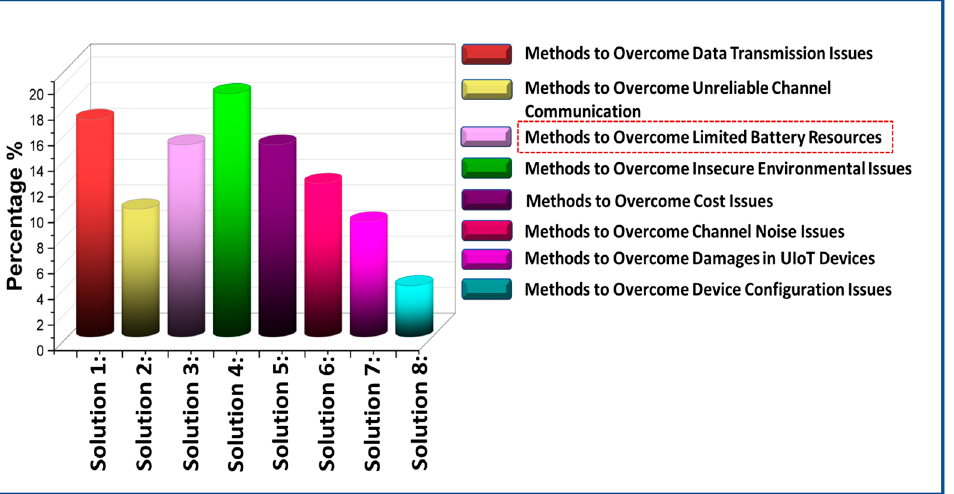
Figure 4. Analysis of techniques developed for battery challenges vs. other challenges in UIoT net- works [58].